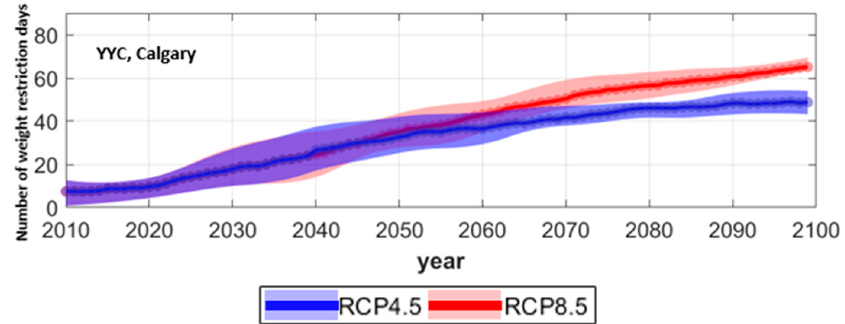
Figure 6. Average number of weight restriction days for 30-year moving windows for summer (JJA) for the 1981 to 2100 period for the RCP4.5 (in blue) and RCP8.5 (in red) scenarios for ( a ) category 1, ( b ) category 2, and ( c ) category 3 aircrafts. The mean values for 30-year widows are plotted at the end of the period, and the shaded region shows the interquartile range for respective windows. Results are shown only for airfields with weight restriction days.